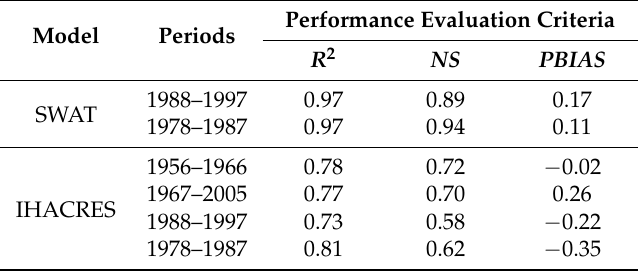
Figure 7. Comparison of observed and simulated annual runoff between the SWAT and IHACRES models in the upper Naoli River Watershed, during 1978–1997. Table 4. Statistical comparison of the observed and simulated annual runoff in the upper Naoli River watershed.